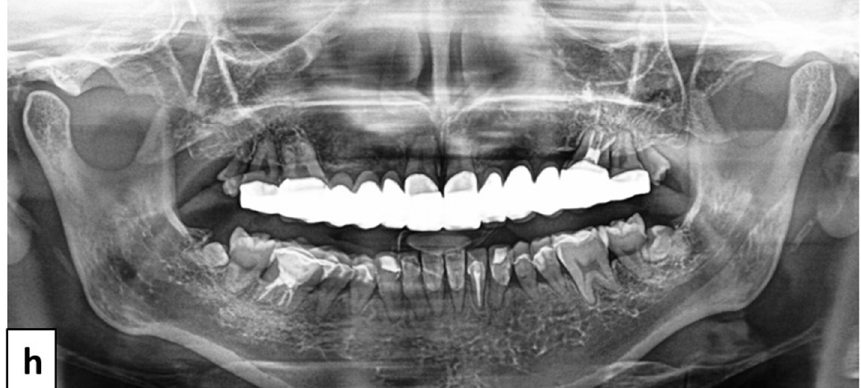
Figure 6. Final maxilla and mandibula rehabilitation. (a–e) Final clinical frontal, lateral views; ( f ) initial occlusal view of the mandibular arch; ( g ) final occlusal view of the mandibular arch; and ( h ) final panoramic X-ray.